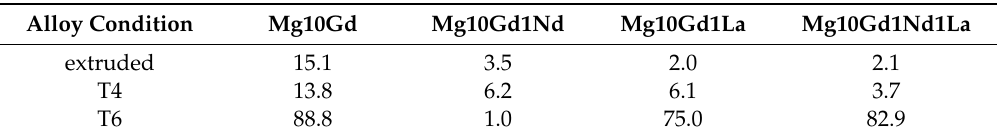
Figure 11. Cross-section macrograph of the samples after corrosion by immersion: ( a ) Mg10Gd1Nd in T6 condition showing no corrosion attack; ( b ) Mg10Gd1La in extruded condition corroded all-over; and ( c ) Mg10Gd1La in T6 condition corroded locally. Table 3. Corrosion by immersion: Pitting factor.